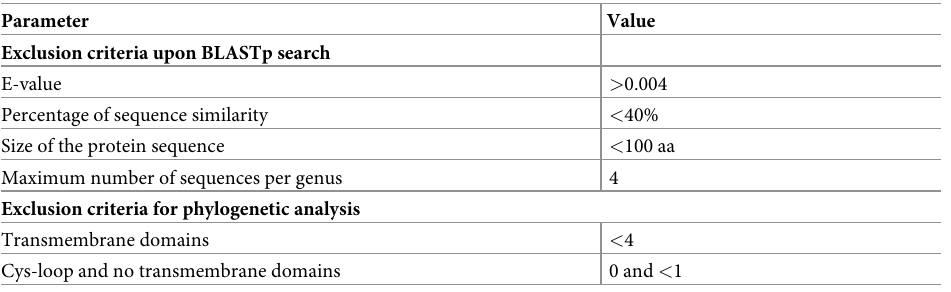
Table 1. Values of parameters for sequence exclusion